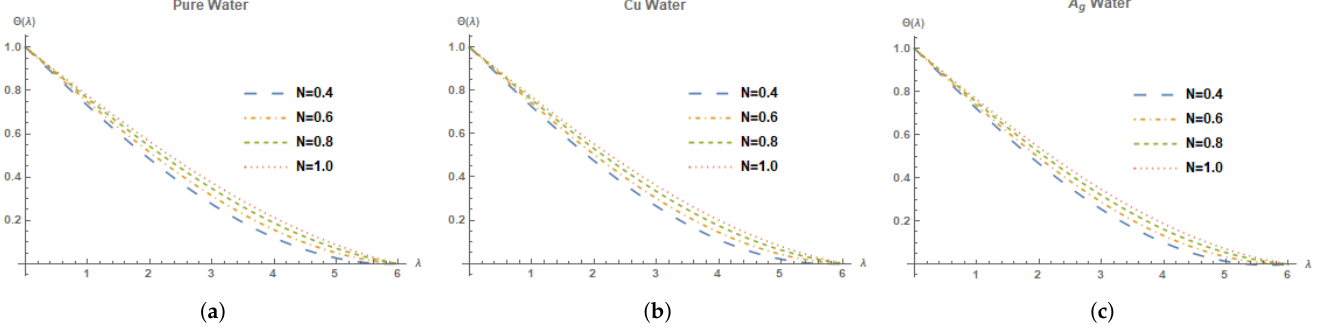
Figure 4. Temperature profile Θ ( λ ) for different choices of conductive radiation parameter N at M = 9, m = 1, P R = 6, χ = π , τ = 0.6, η u = 0.1, Γ = 2, ε = 1, C T = 0.1, S = 1 showing their exciting nature. ( a ) pure-water. ( b ) Cu-water. 6